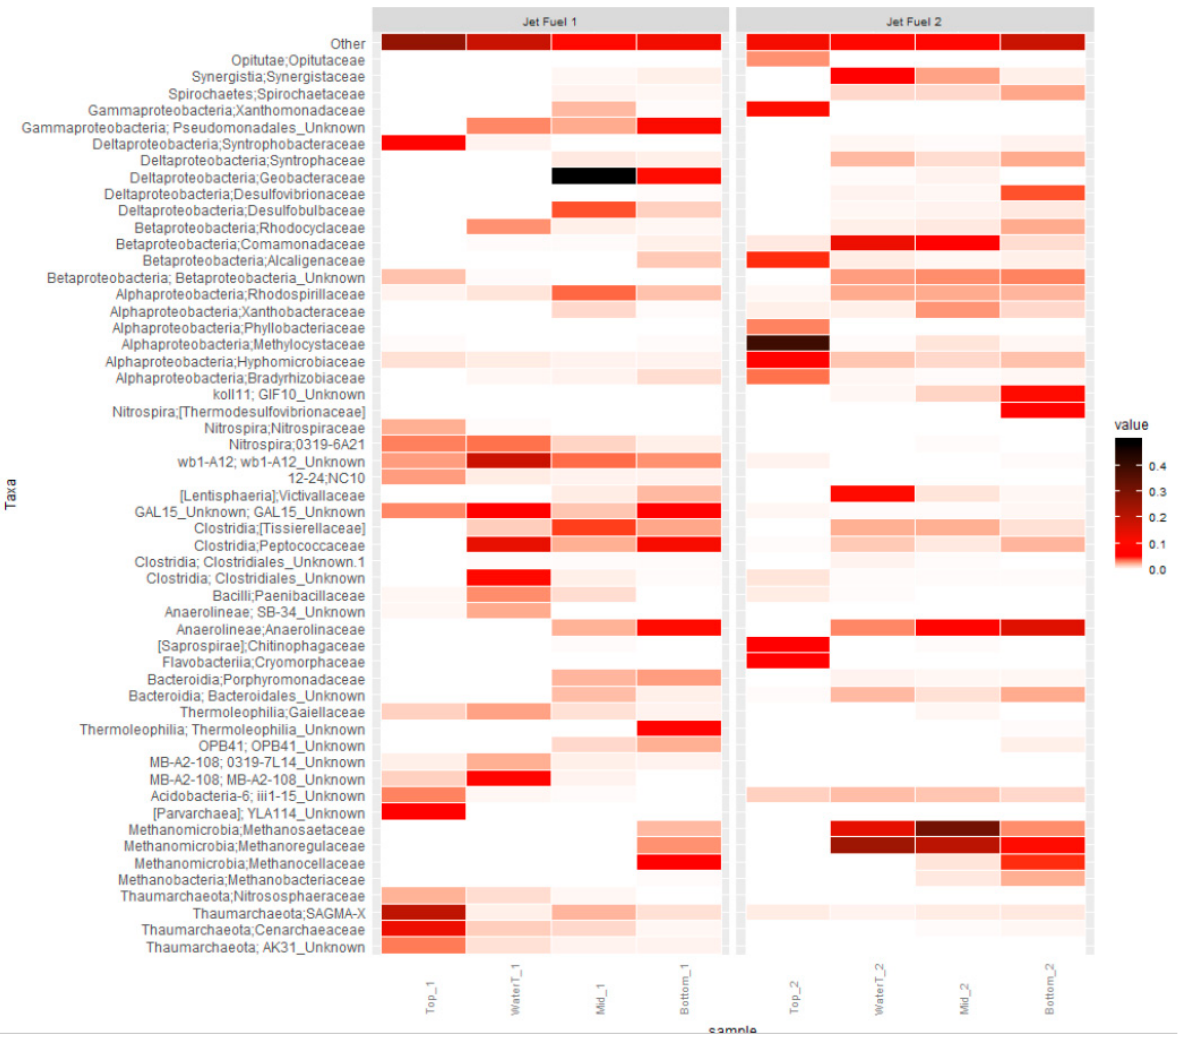
Figure 5. Most abundant taxa in jet-fuel-contaminated cores. Heatmap of the most abundant (>2%) taxa in the jet-fuel- contaminated cores, based on next generation sequencing of 16S rRNA genes.